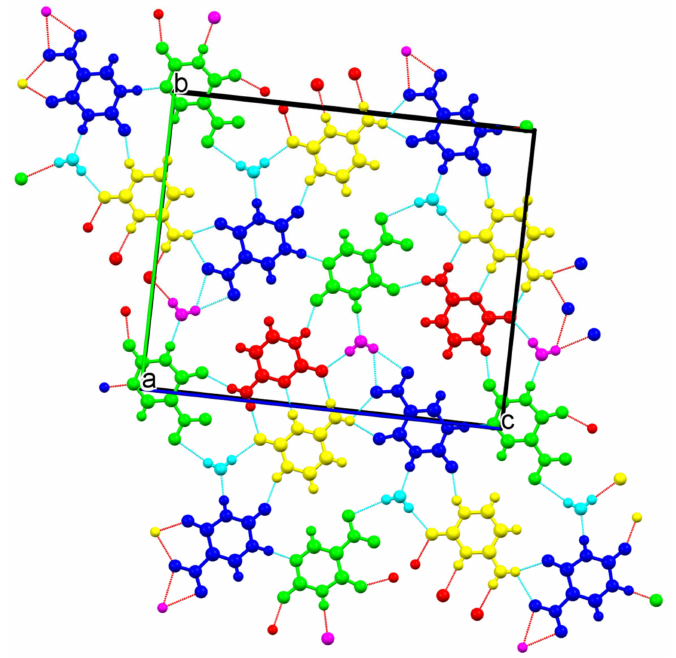
Figure 26. Detail of one of the layers of (XXI) viewed along the a axis. Different colors were used for non-equivalent residues.